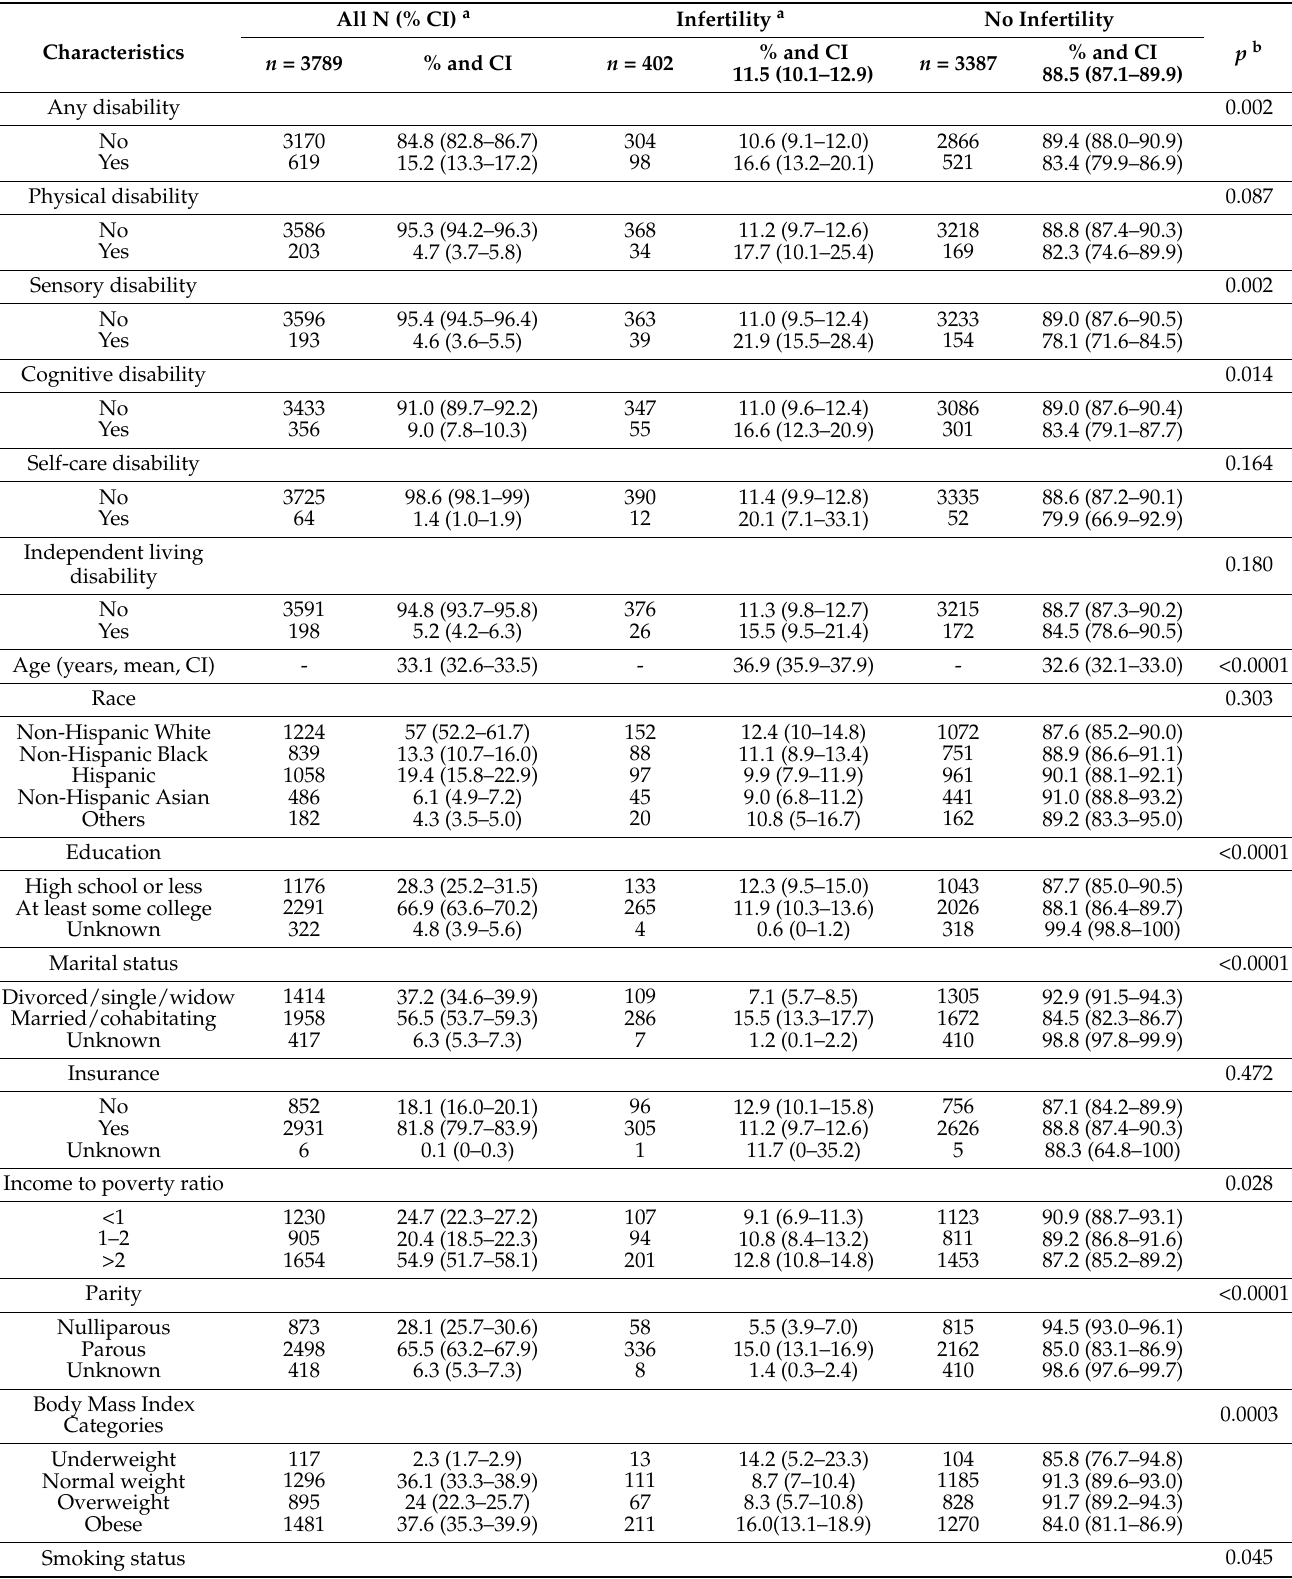
Table 1. Characteristics of study participants by fertility status, NHANES 2013–2018 (unweighted n = 3789).